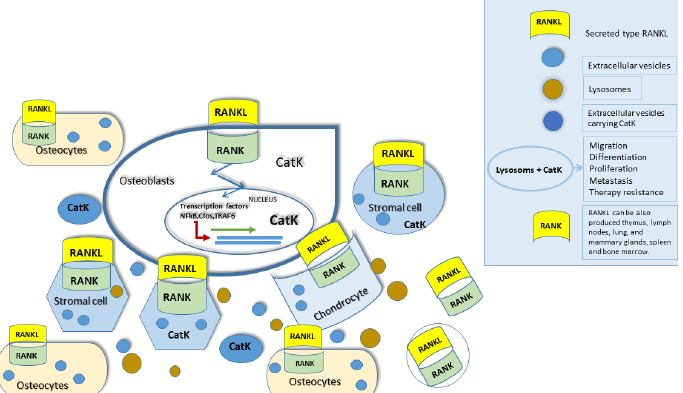
Figure 2. RANK/RANKL signaling. RANKL (Receptor activator of nuclear factor-kappa B ligand) to this date, represents the only known physiological agonist for RANK, its receptor. RANK does not exhibit any kinase activity. Signaling pathway of RANKL/RANK is crucial for skeletal homeostasis and its misbalance affects bone resorption. The outcome of disturbed skeletal homeostasis is the cause for a number of bone diseases, e.g., osteoporosis, rheumatoid arthritis, and osteopetrosis. RANKL/RANK signaling also plays an essential role in lymph node development and in mammary glands in mice, as well as thymic maturation.